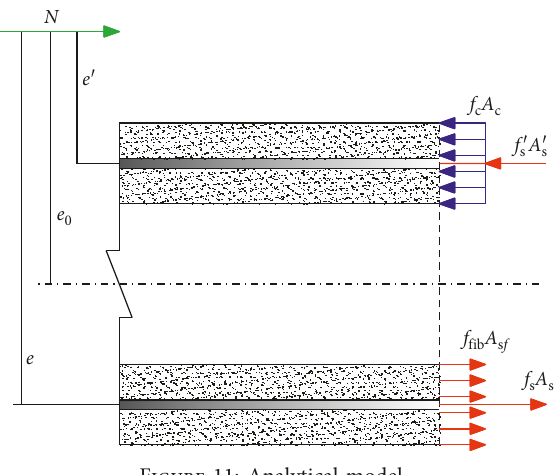
Figure 11: Analytical